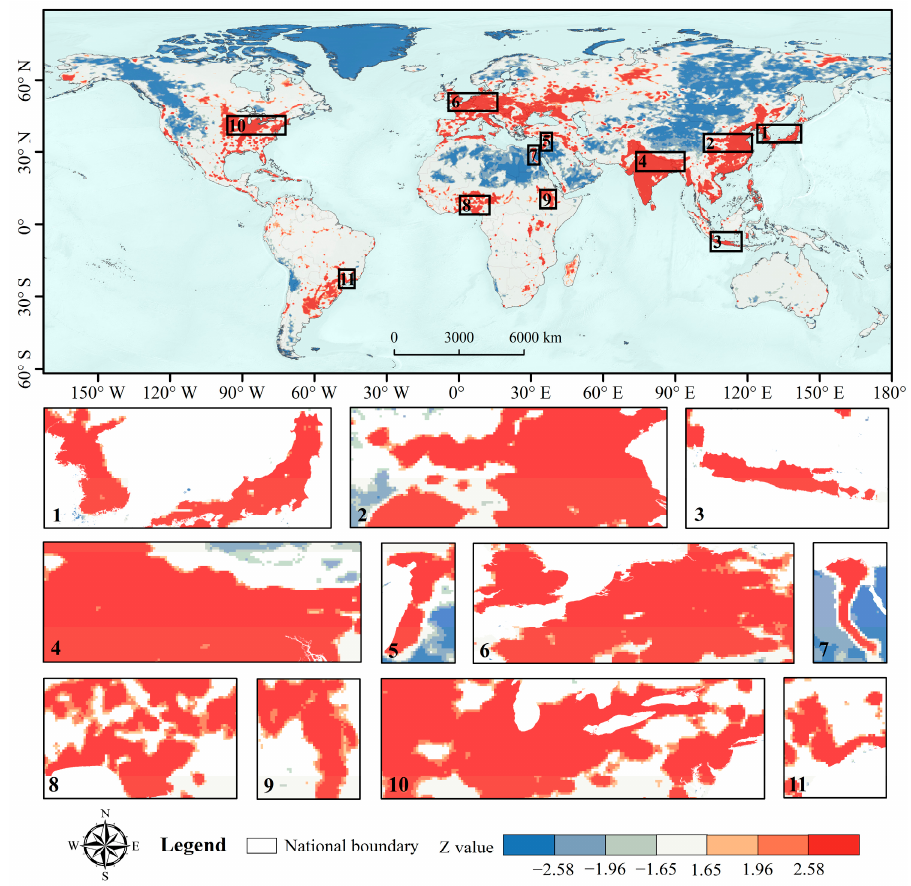
Figure 5. Spatial distribution of global flood risk hotspot regions in 2005.